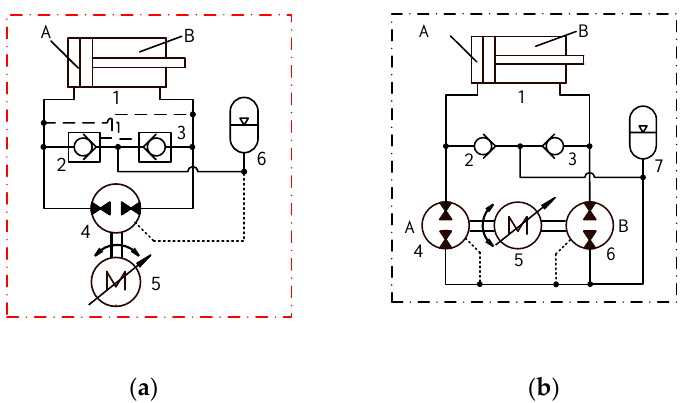
Figure 1. Simplified circuit of the two-pump control system: ( a ) SPC, ( b ) DPC.